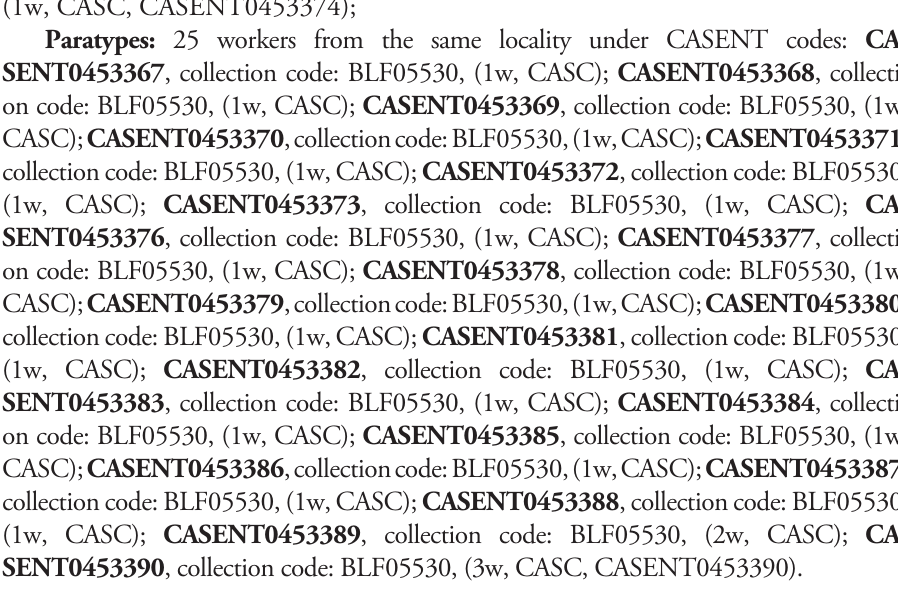
Type material investigated. Holotype: CASENT0453374 , collection